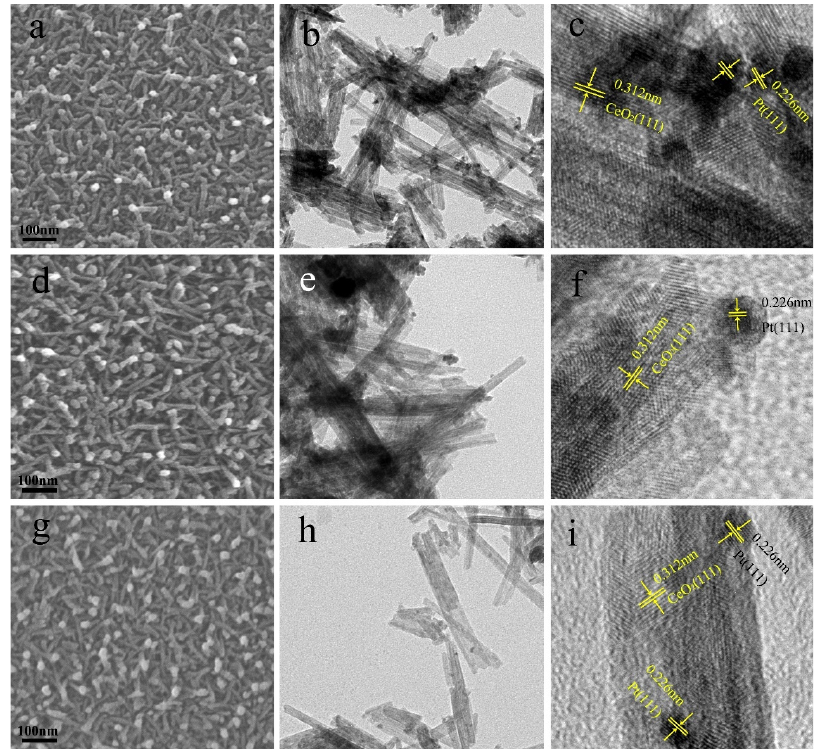
Figure 3. The SEM images of ( a ) (0.3TiO 2 − Pt)/CeO 2 , ( d ) (0.5TiO 2 − Pt)/CeO 2 , and ( g ) (0.7TiO 2 − Pt)/CeO 2 ; the TEM and HRTEM images of ( b , c ) (0.3TiO 2 − Pt)/CeO 2 , ( e , f ) (0.5TiO 2 − Pt)/CeO 2 , and ( h , i ) (0.7TiO 2 − Pt)/CeO 2 .